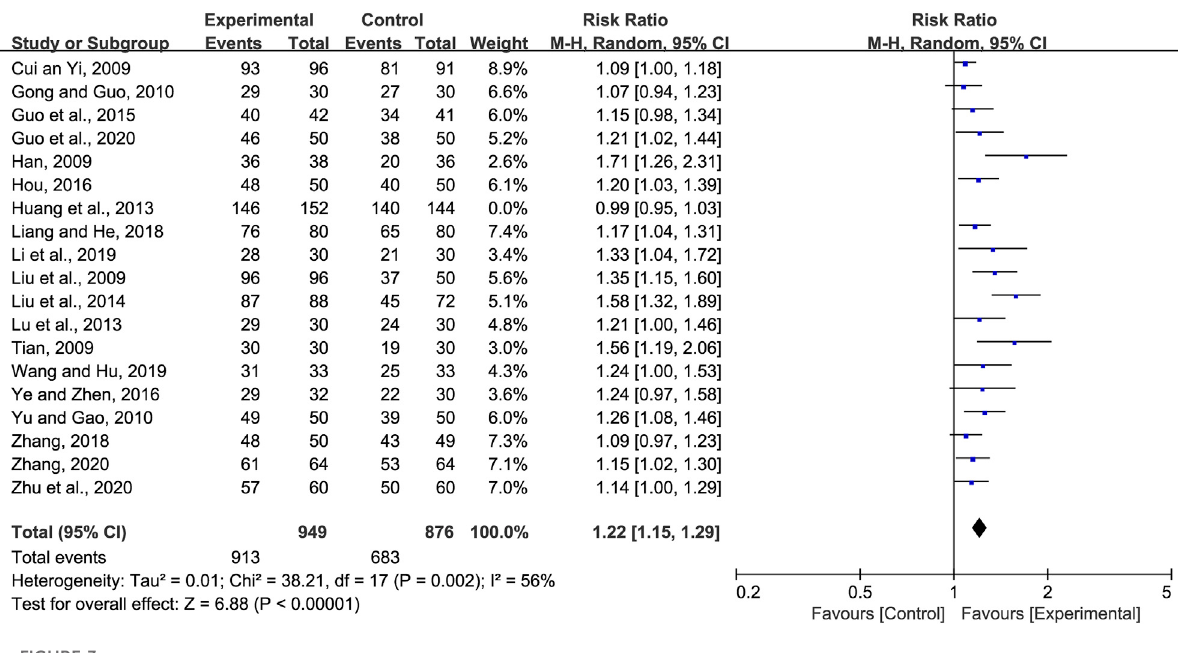
FIGURE 3 Forest plot for the total clinical effective rate.